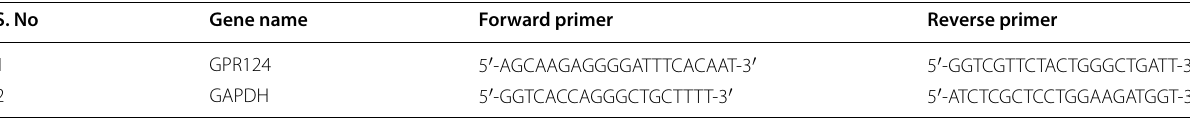
Table 1 List of RT-PCR primers used in this